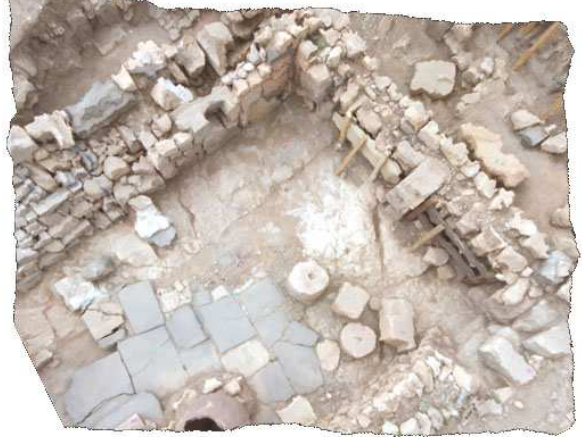
Figure 3. Orthophoto mosaic (rotated) of ca. 70 m 2 of the